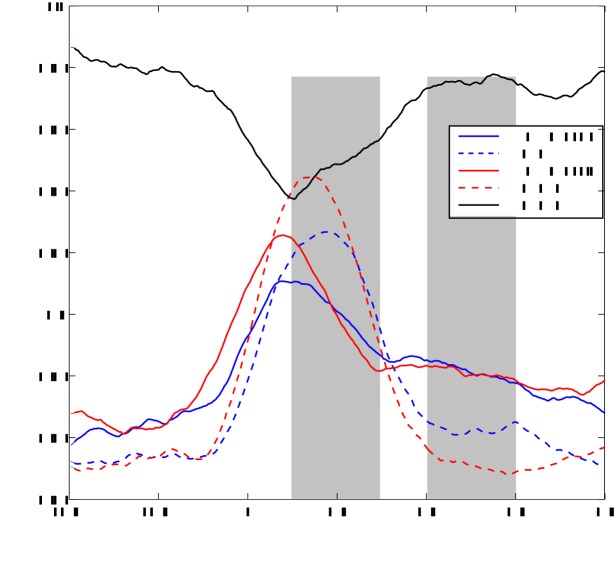
Phase-locking value in the auditory cortex time-locked to temporal speech edges.Phase-locking in theta frequency band between low-frequency speech envelope and the left (PLV speech L, blue solid line) and right (PLV speech R, red solid line) auditory cortex is shown following edge onset at 0 ms. Dashed lines show phase-locking across trials (regardless of speech signal) timelocked to edge onset for left (PLV L, blue dashed line) and right (PLV R, red dashed line). The black line represents phase-locking between the left and right auditory cortex.